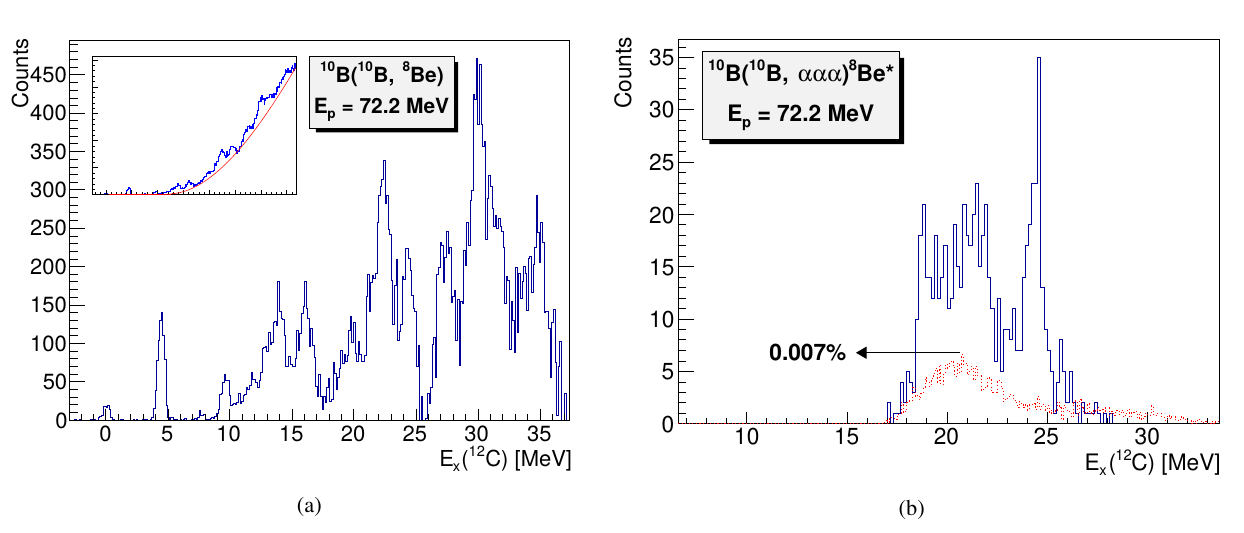
Figure 1: ∆ E-E spectrum for the 10 B + 10 B nuclear reaction measured at 72.2 MeV. Figure 2: The results for 12 C measured in (a) double and (b) triple α coincidences (see text for details). The (red) dotted line in (b) shows the corresponding Monte Carlo e ffi ciency curve.